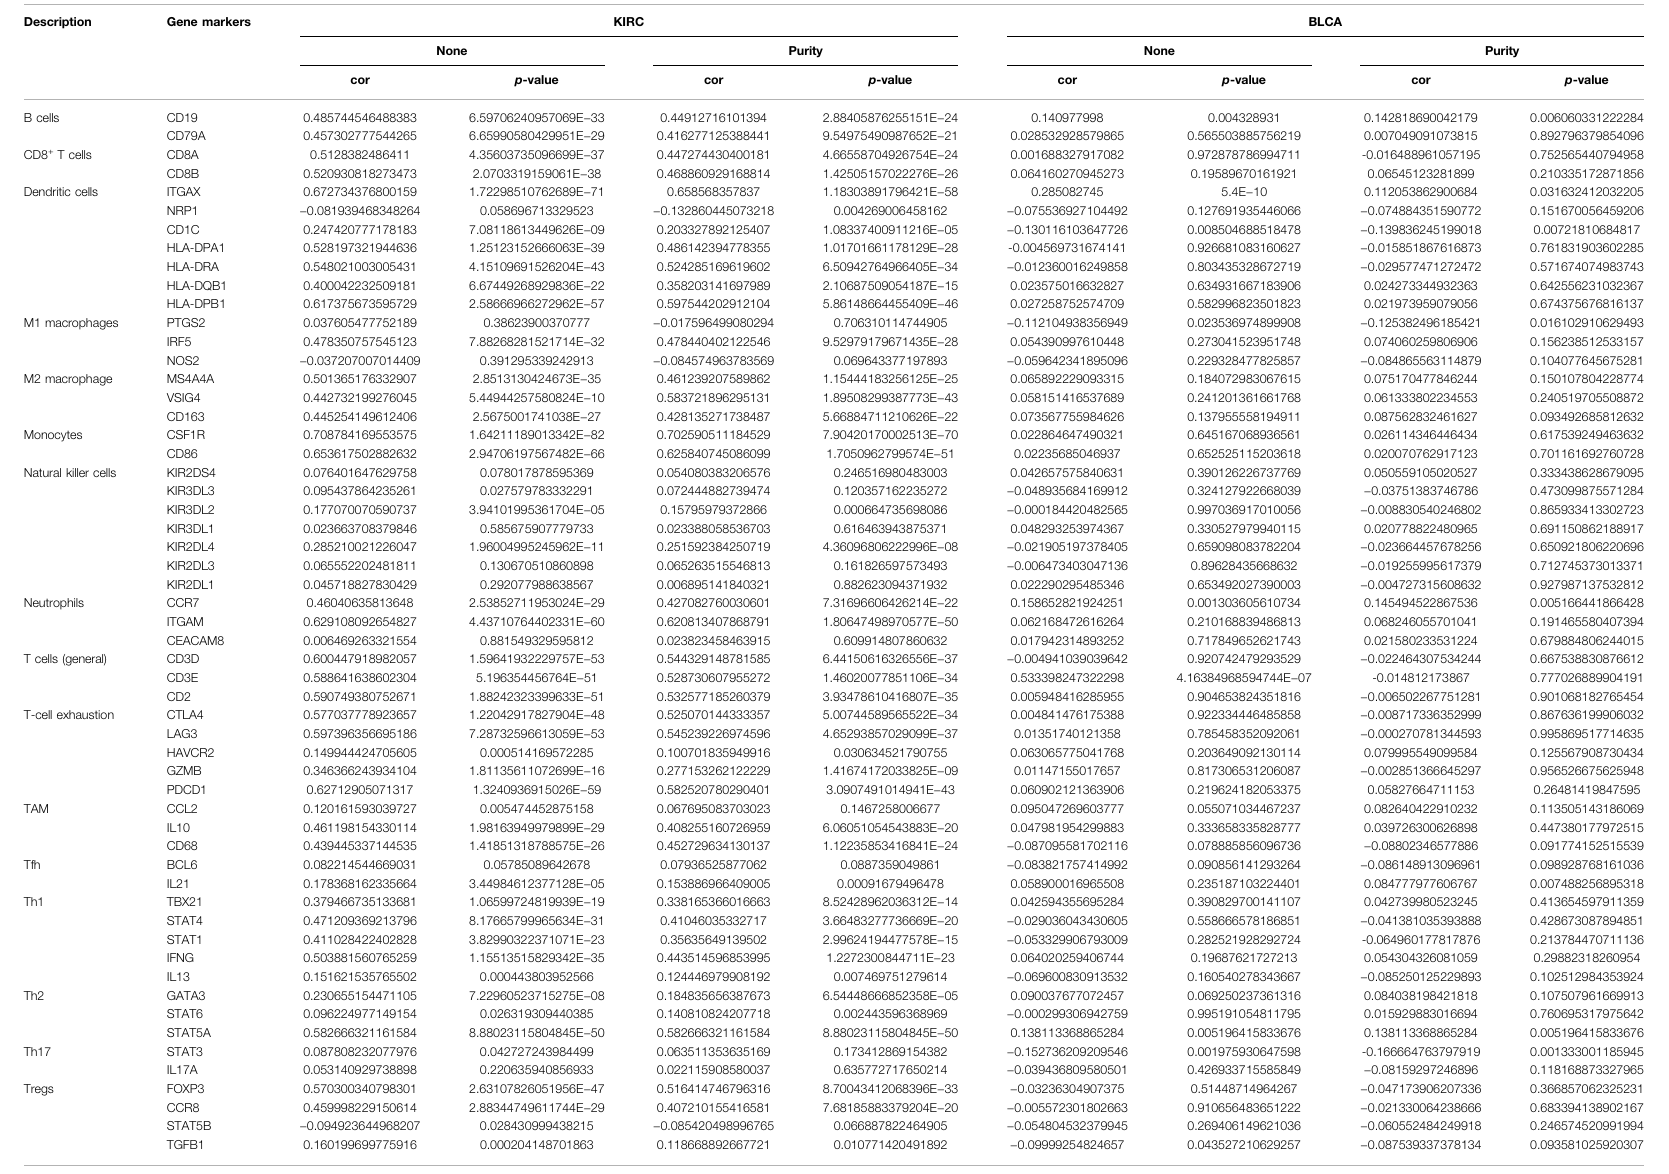
TABLE 1 | Correlation analysis between TRPM2 and the gene markers of different immune cells in kidney renal clear cell carcinoma (KIRC) and bladder urothelial carcinoma (BLCA) in TIMER 2.0 database.